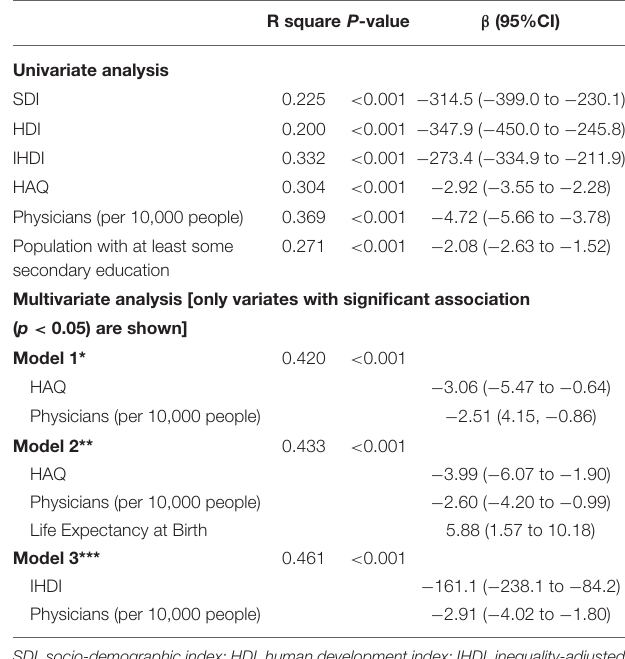
TABLE 1 | Linear regression analysis of the relationship between the country-level disease burden of CKD due to hypertension and the socioeconomic variables. R square P